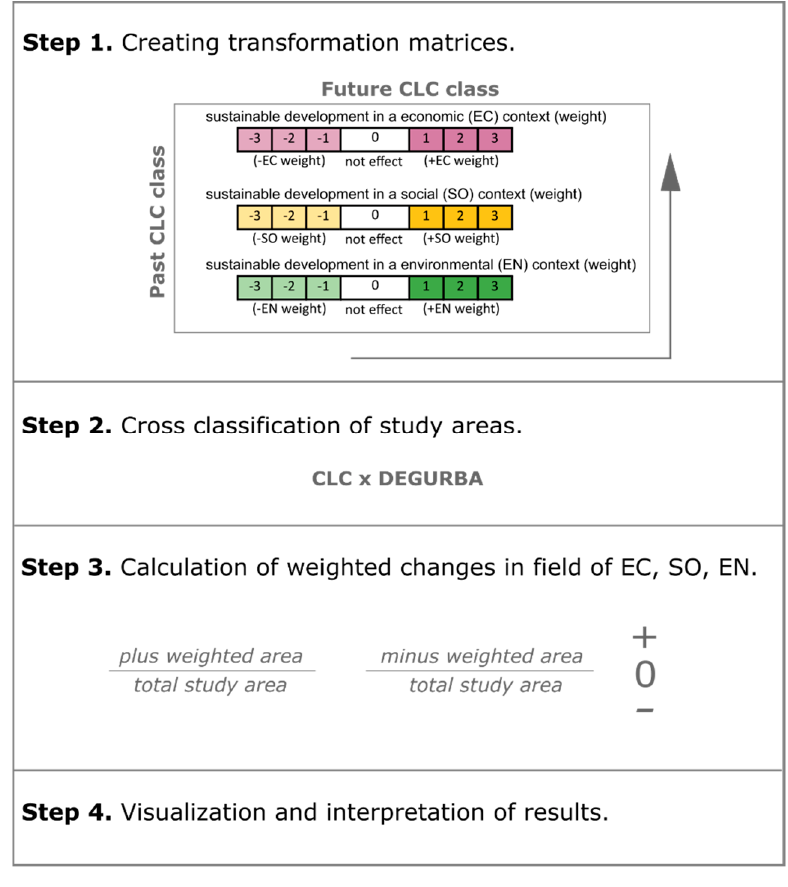
Figure 1. Methodology flow chart research.